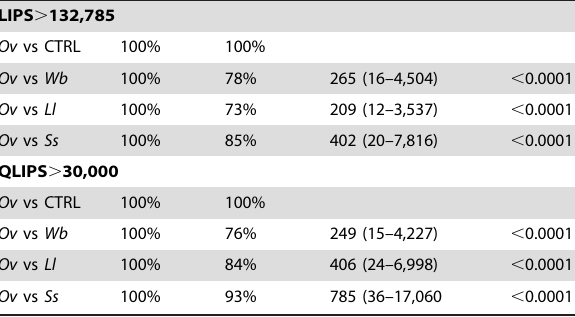
Table 4. Sensitivity, specificity, and odds ratio for the four- antigen mixture determined by LIPS and